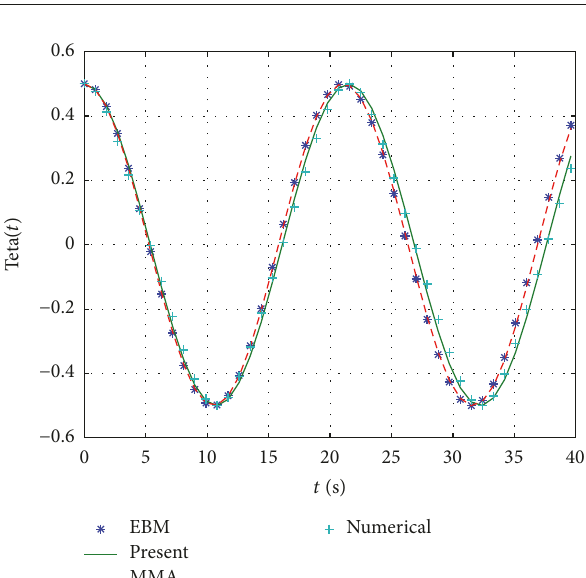
Figure 5: A comparison between the approximate and numerical solutions with Λ = 1 and 𝐴 = 0.5 , Example 2.